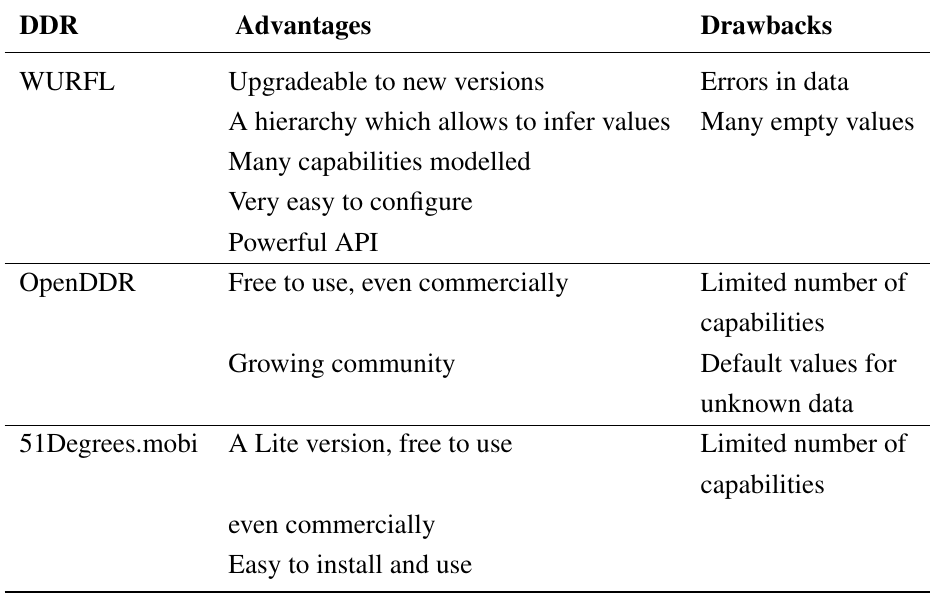
Table 4. Analysed DDRs comparison